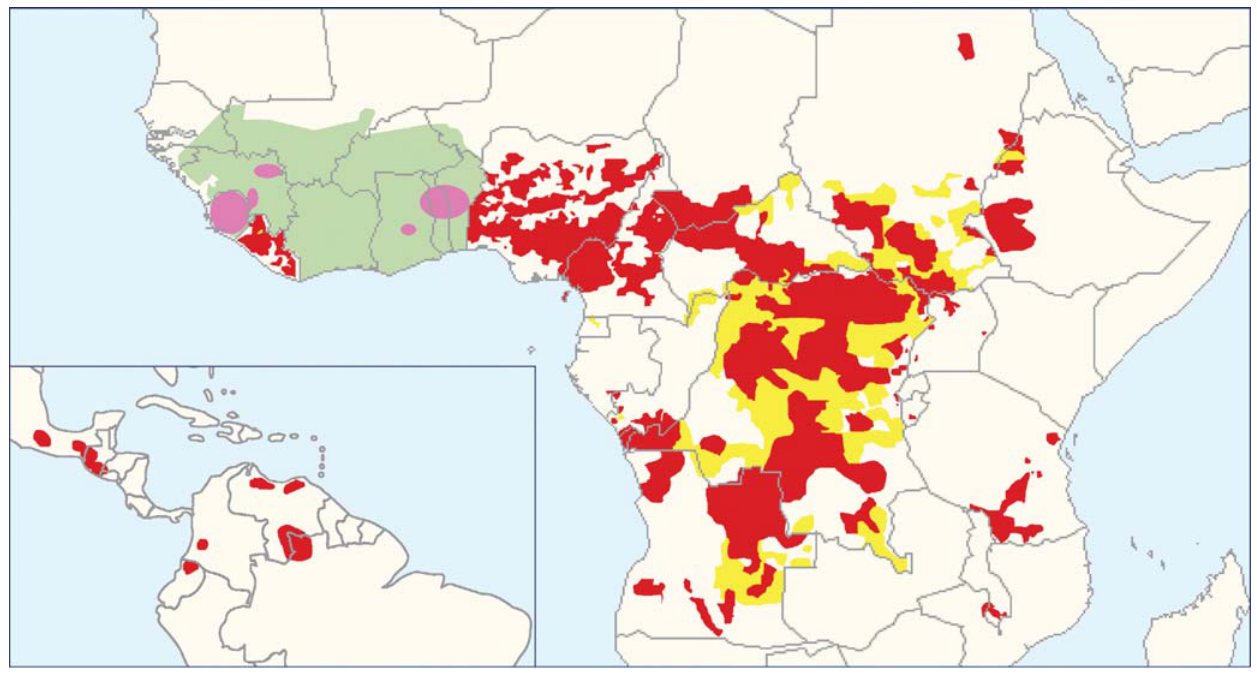
Figure 1. Distribution of Onchocerciasis Showing Current Status of Global Onchocerciasis Control. Red shading represents areas receiving ivermectin treatment. Yellow shading represents areas requiring further epidemiological surveys. Green shading indicates the area covered by the OCP in West Africa. Pink zones indicate the special intervention zones, i.e., previous OCP areas receiving ivermectin and some vector control. Figure from